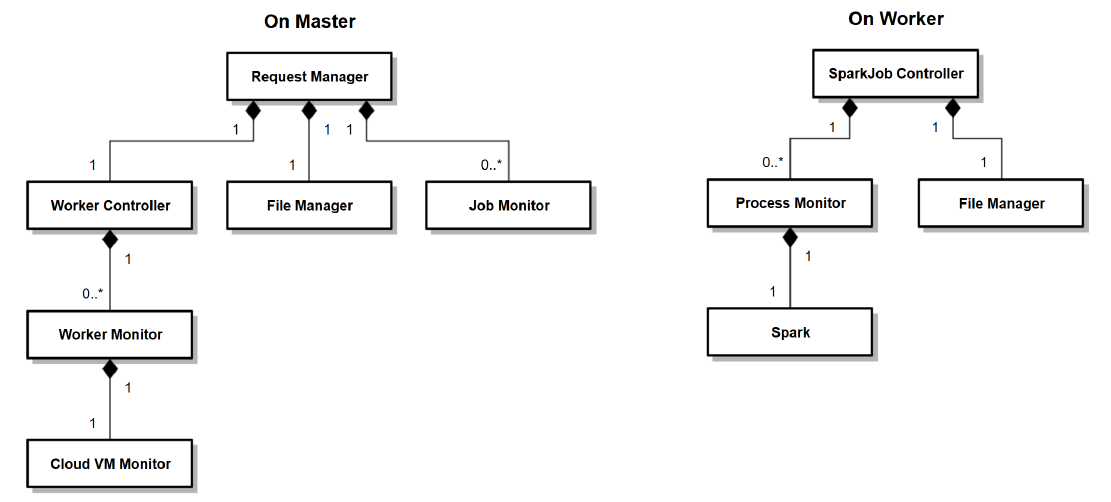
Figure 3. SparkCloud class